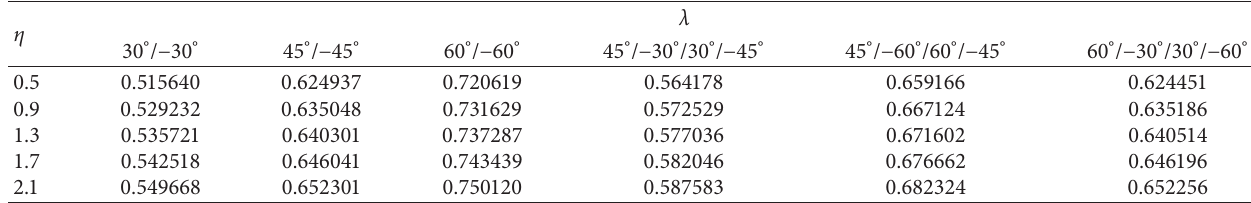
Table 3: Fundamental frequency parameter value with taper ratio for different stacking sequences.